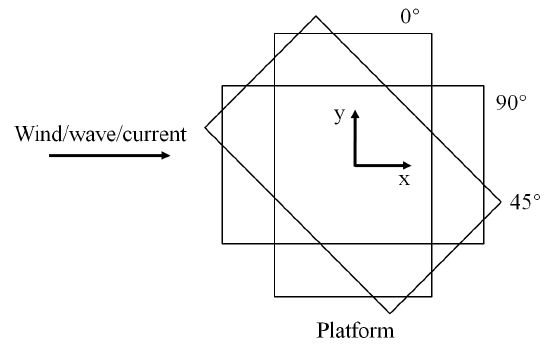
Figure 2. The experimental layout of the electrical platform model.